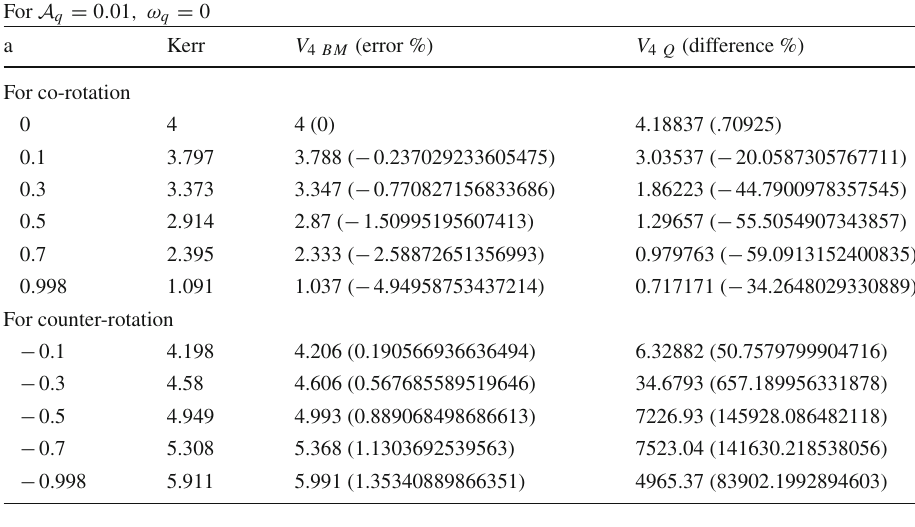
PNPs for moderate DE effect of a BH embedded in